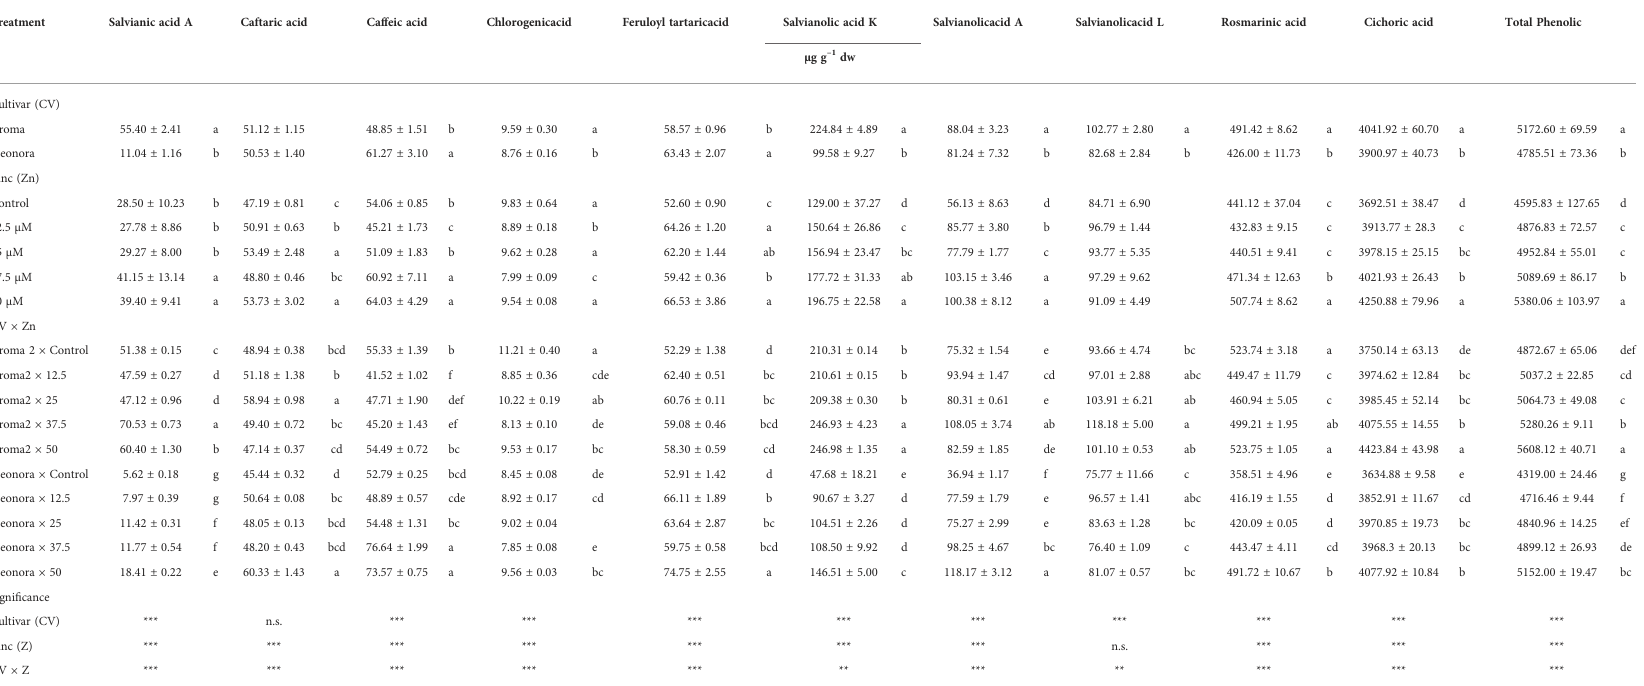
TABLE 5 Analysis of variance and mean comparisons for phenolic pro fi le of Aroma 2 and Eleonora basil cultivars grown hydroponically under different Zn treatments: 0 = Control; 12.5; 25; 37.5; 50 µmol of Zn].